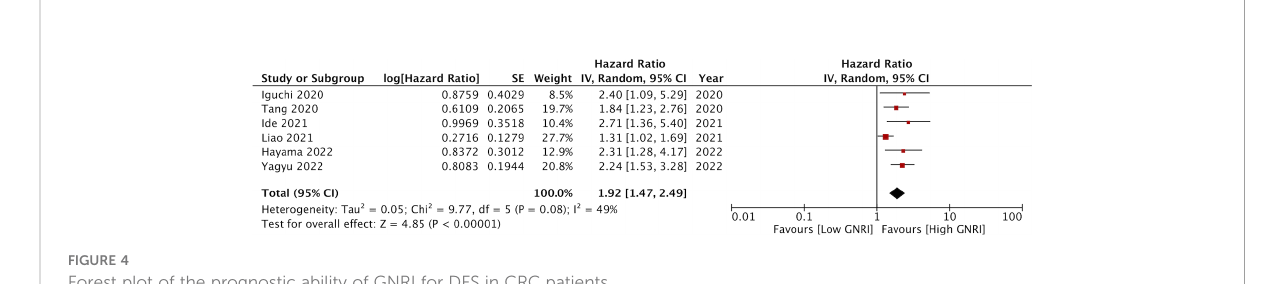
FIGURE 4 Forest plot of the prognostic ability of GNRI for DFS in CRC patients.